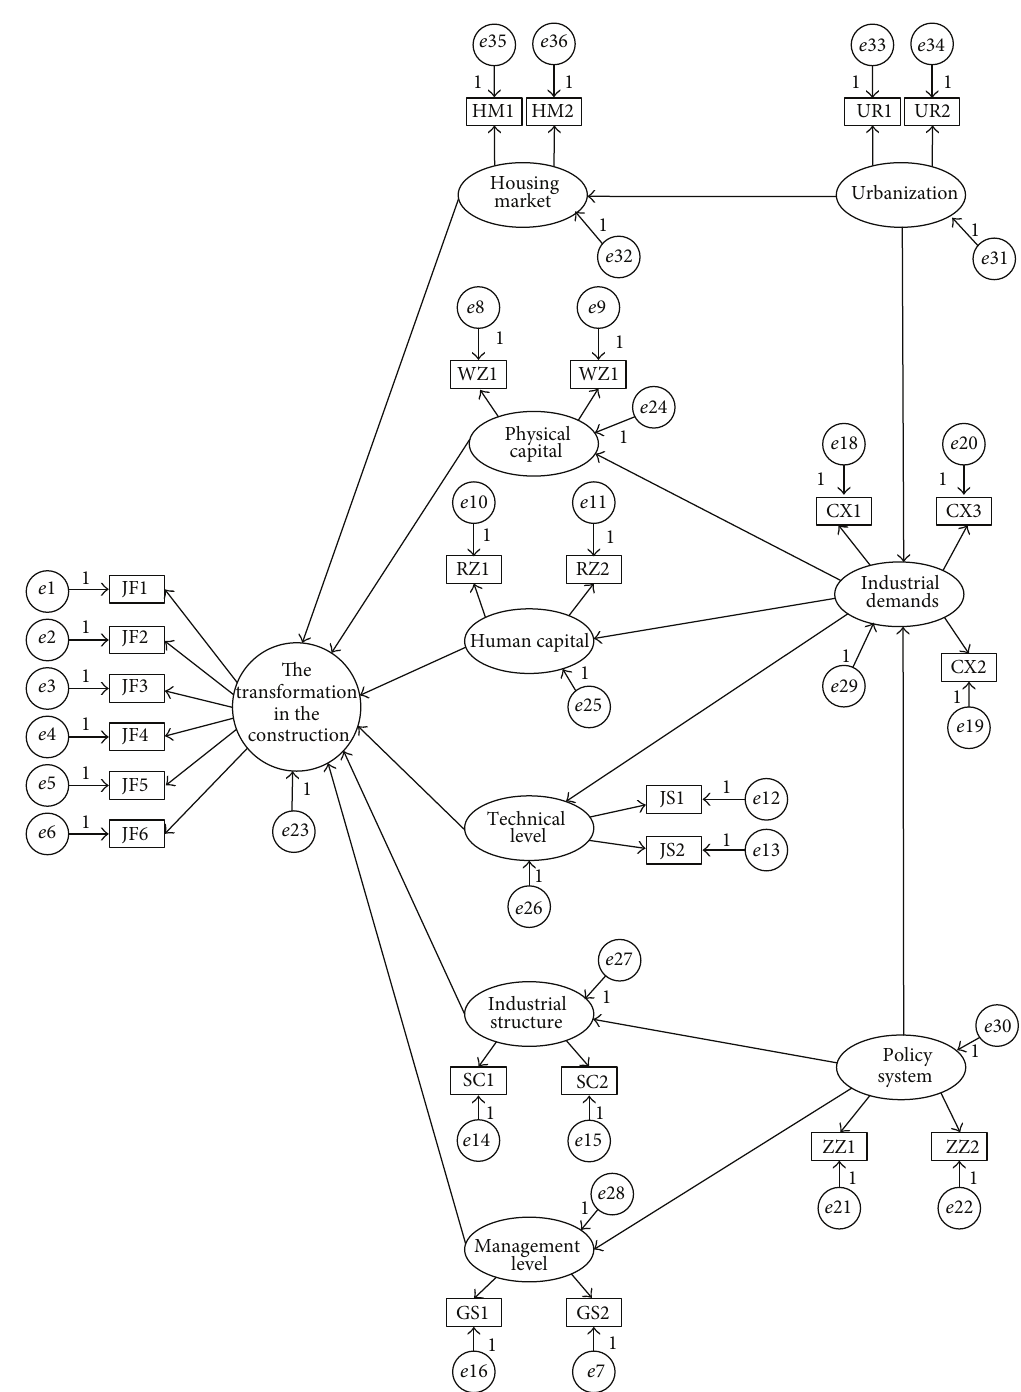
JF6JF5JF4JF3JF2JF1 Figure 1: The initial set of structural equation